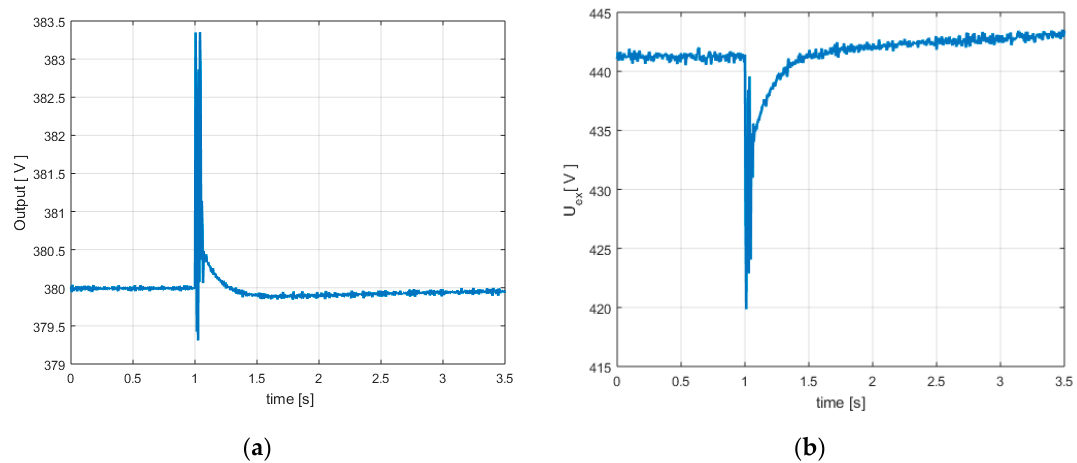
Figure 10. Resistive load—5th order model: ( a ) Terminal voltage (controlled output); ( b ) Excitation voltage (controller output).